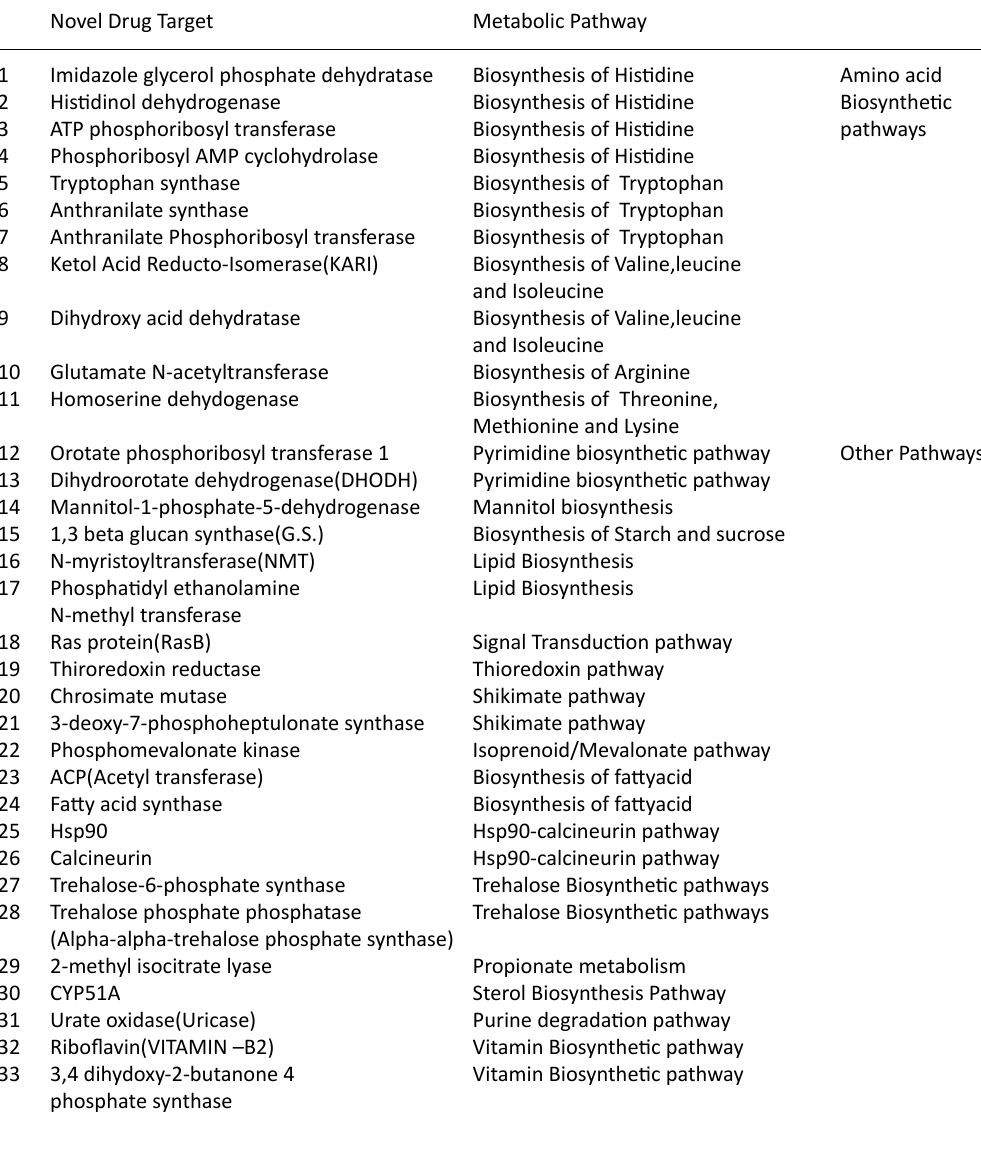
table 1. List of novel drug target of Aspergillus fumigatus and their metabolic pathway Novel Drug Target Metabolic